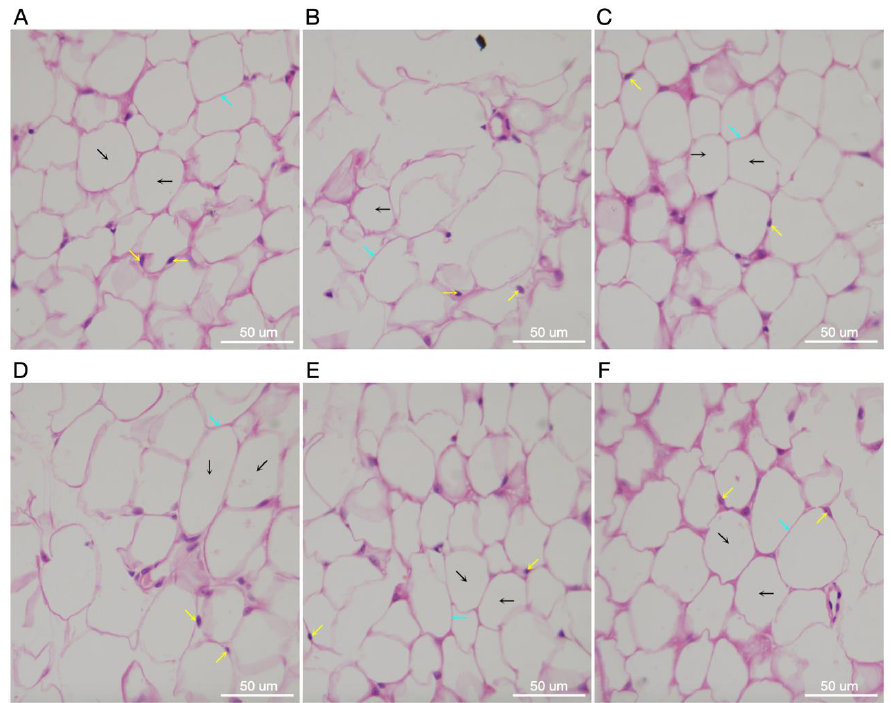
Figure 7. Photomicrographs of adipose tissue of controls and treated experimental animals. ( A ) The control group showed polygonal fat cells (black arrow) with a nucleus (yellow arrow) and distinct polygonal-shaped cells (light blue arrow). ( B ) The diabetic control group showed large-sized polygonal fat cells (black arrow) with scattered nuclei (yellow arrow) and distorted fat cells outlines (light blue arrow). ( C ) Showing recovered fat cells near to normal with GLB treatment. ( D ) Showing recovering adipose tissue fat cells with few nuclei and distorted polygonal fat cells after treatment with 200 mg/kg TME. ( E ) Shows apparent improved polygonal fat cells (black arrow) with well-shaped cellular outlines (light blue arrow). ( F ) Represents treatment with UFN also showing recovered adipose tissue fat cells (black arrow) with defined cellular outlines (blue arrow) but not as distinct as in the diabetic control group. H&E, × 1000. STZ; streptozotocin HFD; high-fat diet, STD GLB; standard glibenclamide, TME; total methanol extract, UFN;